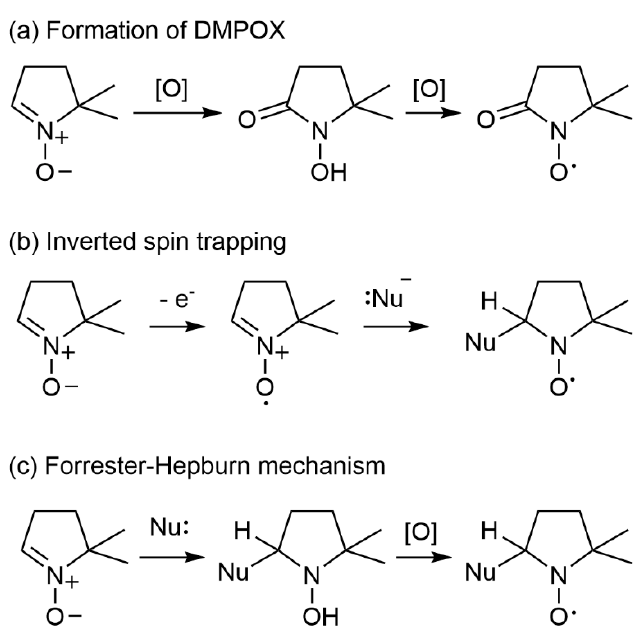
Figure 10. Pathways leading to artefactual detection of nitroxides in spin trapping experiments: ( a ) formation of the DMPOX nitroxide characterized by a 7-line EPR spectrum under oxidizing conditions; ( b ) inverted spin trapping; and ( c ) Forrester-Hepburn mechanism. DMPO is used as a model spin trap in this figure, but similar mechanisms exist for other nitrones. [O] stands for the oxidation step, and Nu: for nucleophiles such as thiols.